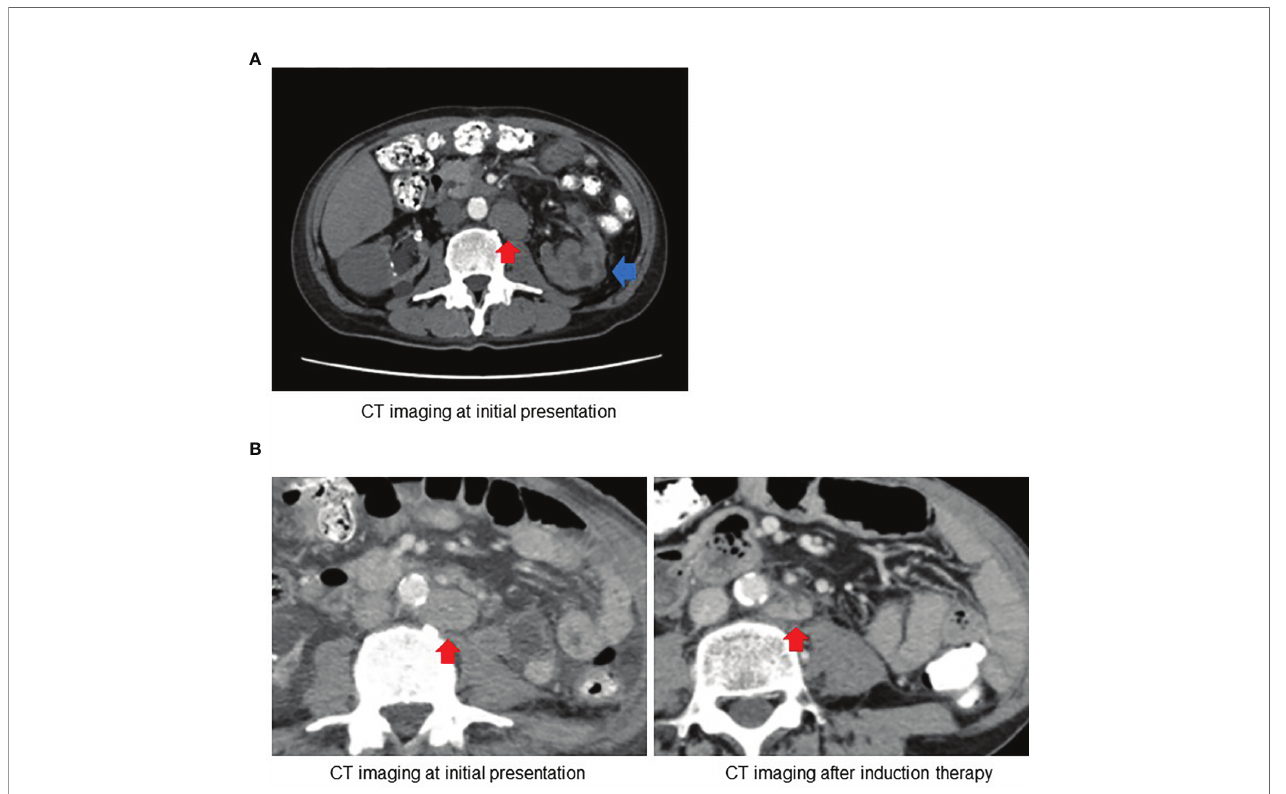
FIGURE 1 | (A) Computed tomography (CT) at initial presentation revealed the left kidney tumor (blue arrow) with para-aortic lymph node involvement (red arrow). (B) Follow-up CT after induction therapy with ipilimumab and nivolumab showed substantial decrease in size of para-aortic lymph